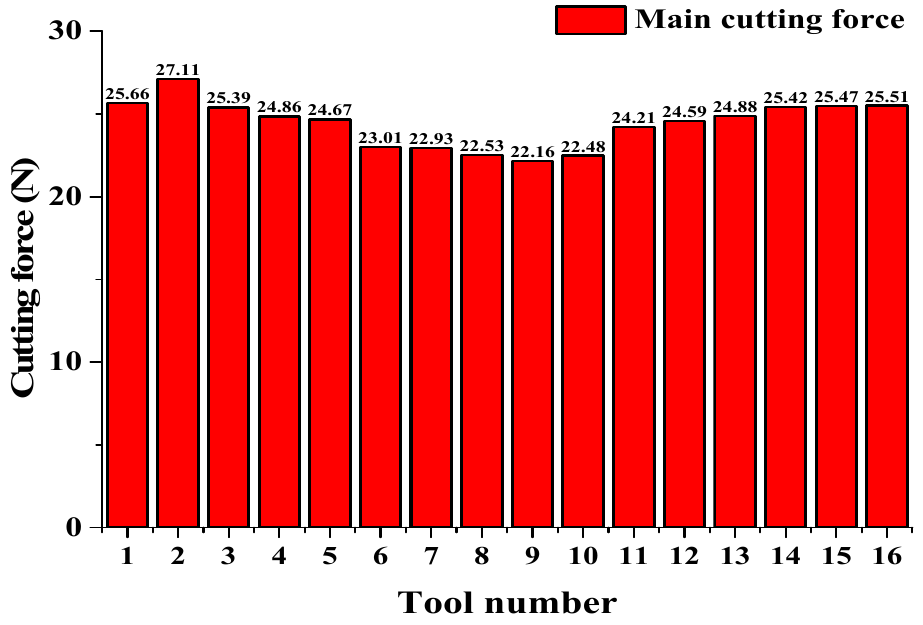
Figure 11. Main cutting force of non-textured Tool 1 and textured PCD Tools 2 to 16. In micro-cutting, the texture parameters can change the contact state of the sticking and the sliding area. In the sliding area, the contact force and tool wear are lower because the friction coefficient is smaller in this region and the SiC particles roll in the interface.